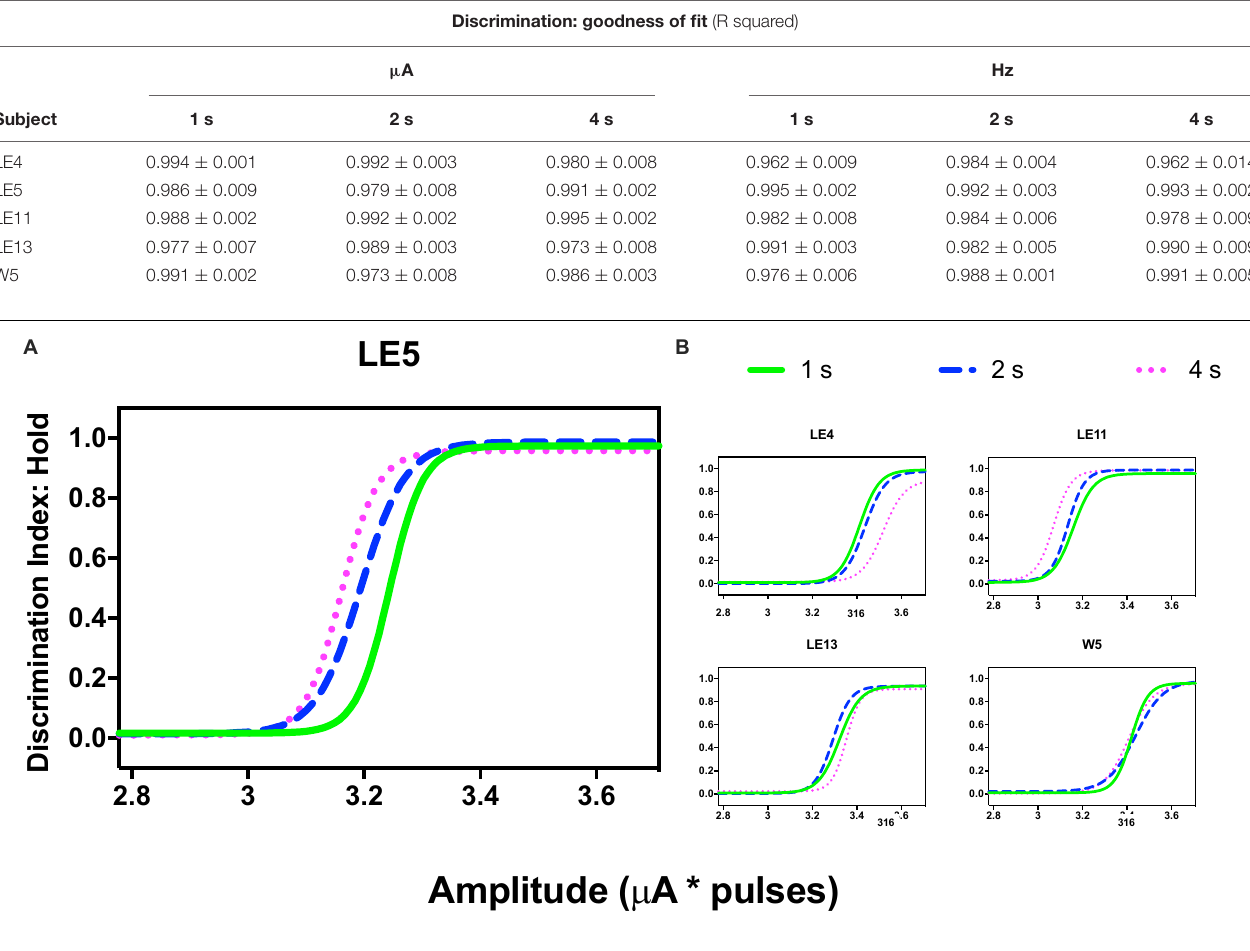
FIGURE 8 | Discrimination Index as a function of variations of intensity (in common scale, see text) and price (hold requirements). Abscissas in log scale. (A) Exemplar rat. (B) Remaining rats.